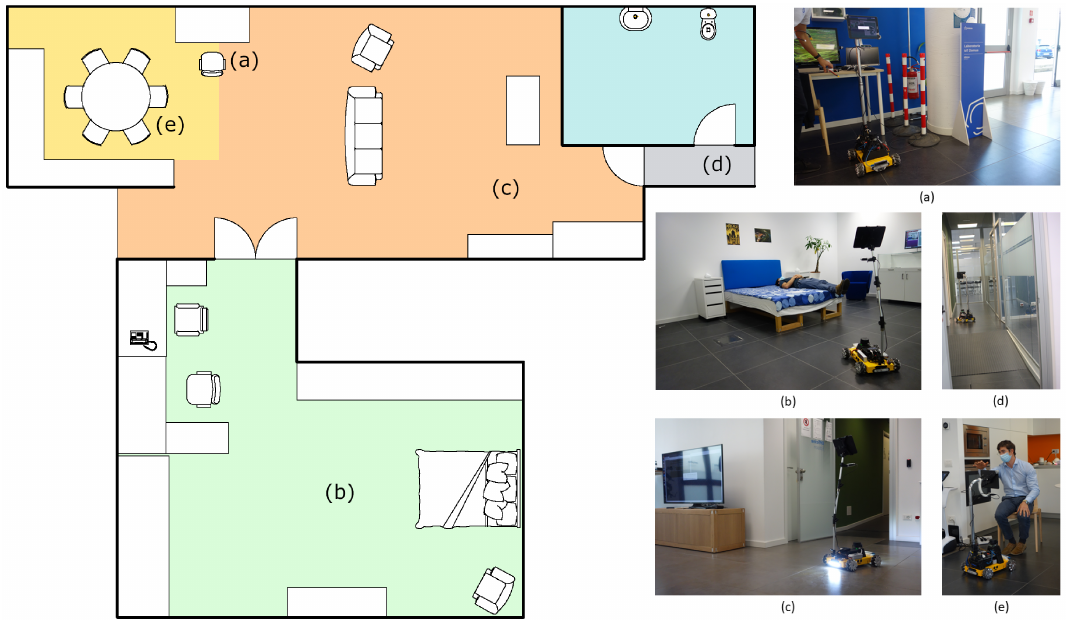
Figure 9. Simplified map of the Domus area at Officine Edison, Milan, with the four rooms, kitchen, living room, bedroom, and bathroom, respectively in yellow, orange, green, and blue. Letters on the map indicate the various goals saved in the environment, associated with the corresponding image: ( a ) starting point, ( b ) bedroom keypoint, with user’s pose recognition, ( c ) living room